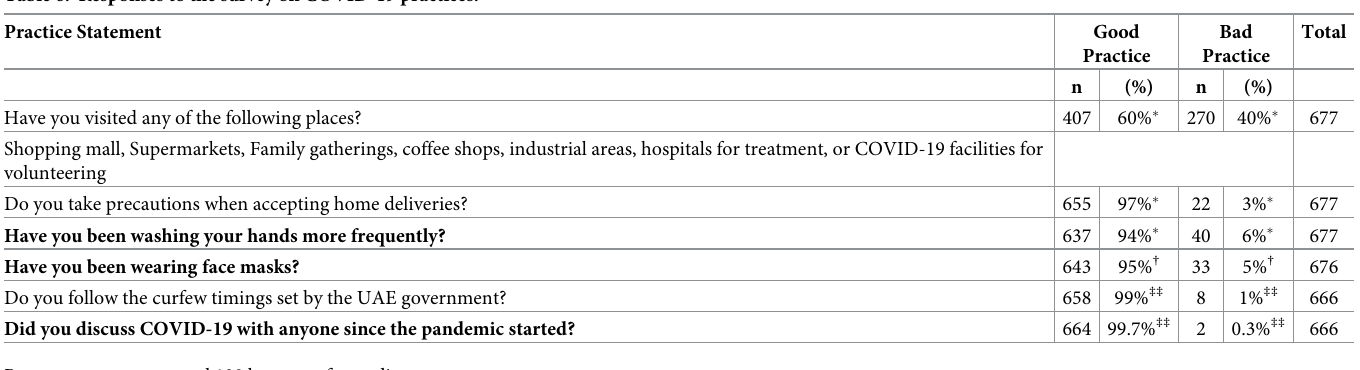
Table 6. Responses to the survey on COVID-19